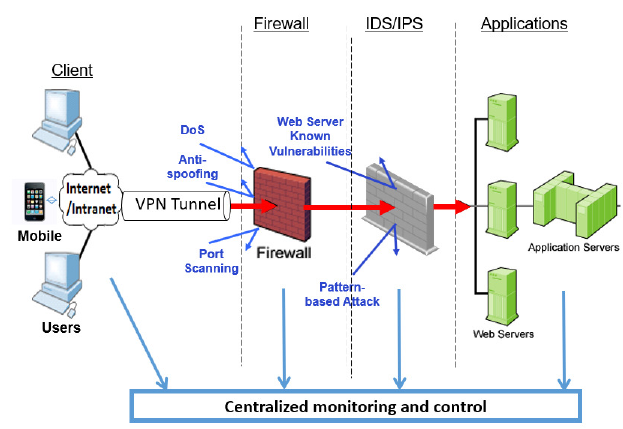
Figure 1. Networks Intrusion detection system